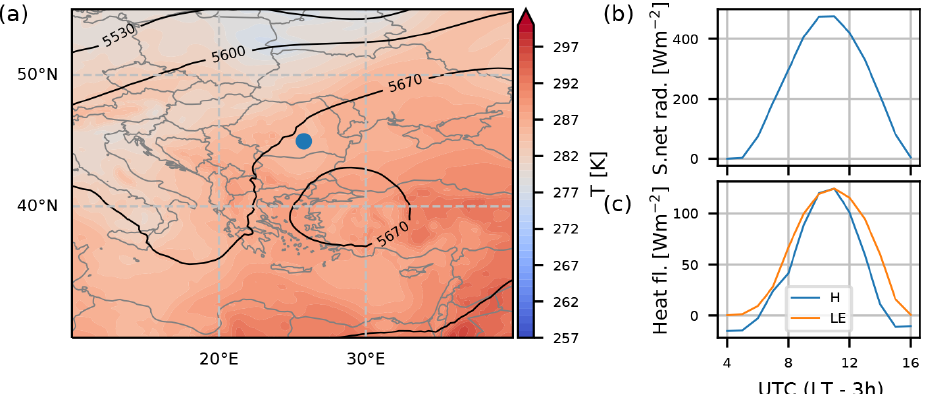
Figure 2. Meteorological situation over SE Europe on 17 October 2019. (a) Geopotential height (m) at the 500hPa pressure level and temperature at 850hPa at 12:00UTC. The location of the studied region is indicated on the map by a blue circle. (b) Surface net solar radiation; (c) hourly values of sensible and latent heat at the location of the